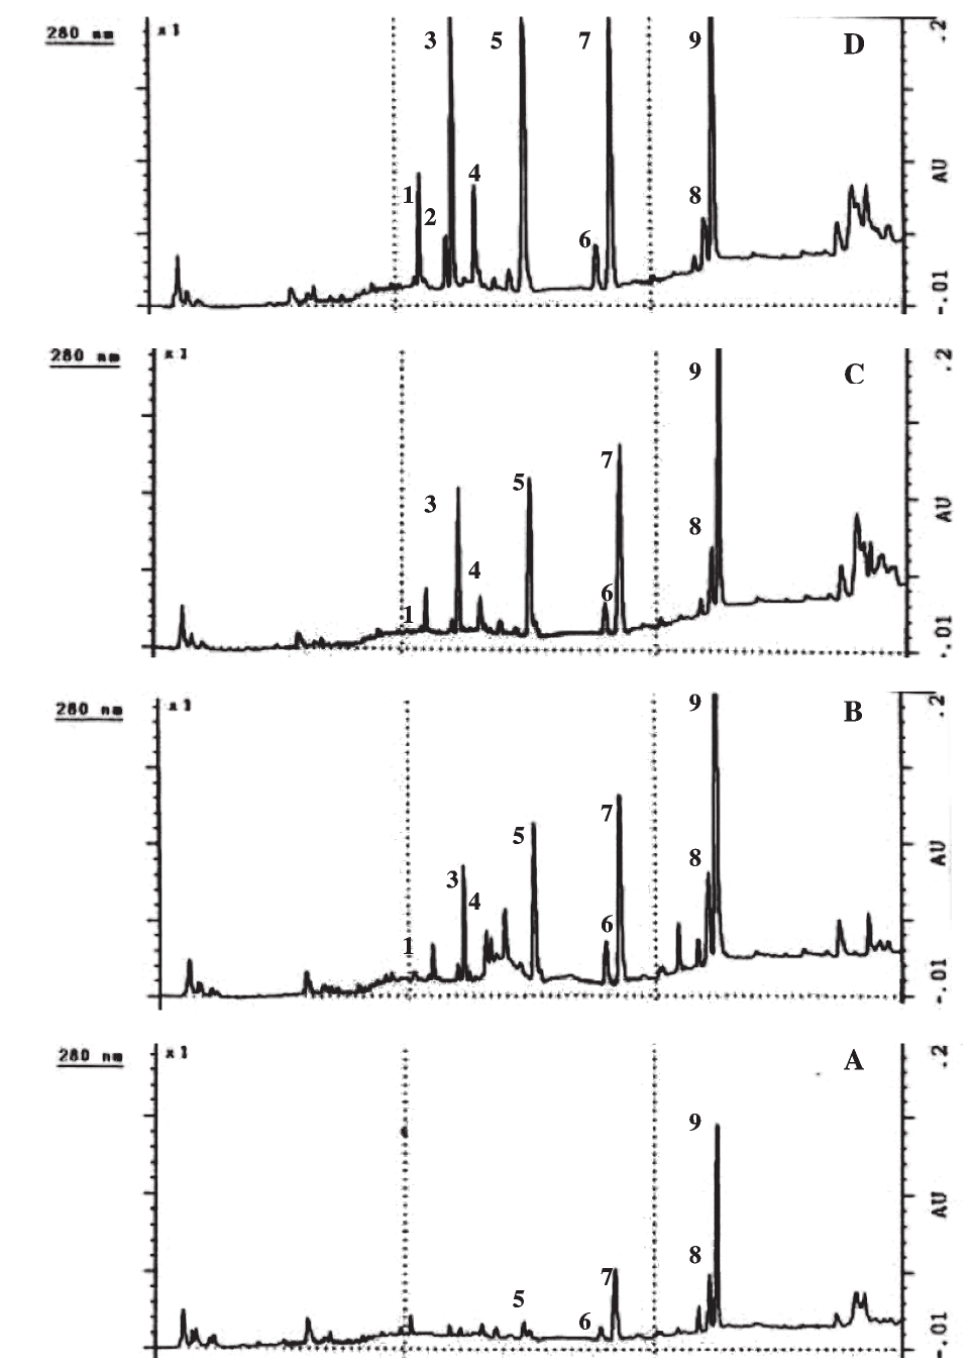
Fig. 2. HPLC profiles of phenolic extracts at 280 nm from the roots of chickpea cv. ILC482 subjected to various treatments. A, control; B, roots bacterized with Rhizobium isolate PchDMS; C, roots inoculated with Foc; D, roots bacterized with Rhizobium isolate PchDMS and inoculated with Foc. Peaks: 7, formononetin; 1 and 3, formononetin glycoside conjugates; 9, biochanin A; 4 and 5, biochanin glycoside conjugates; 2, 6 and 8, non-identified